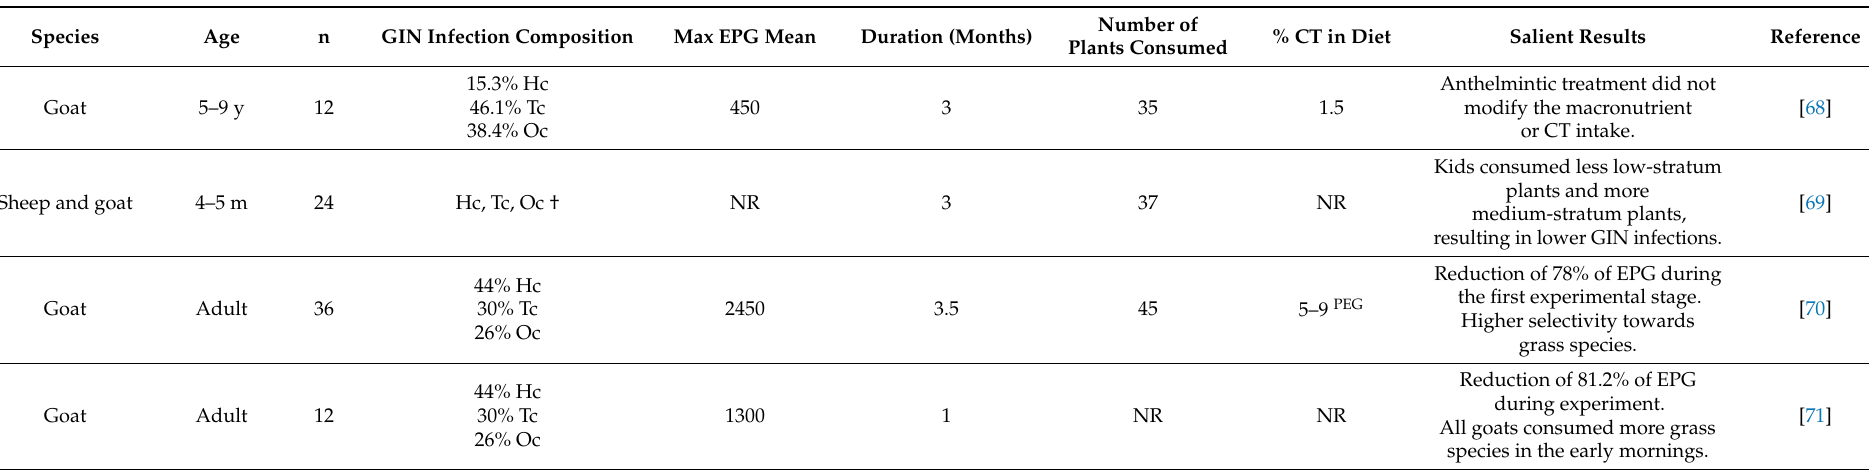
Table 3. Interactions between the natural gastrointestinal nematode infection and the feeding behavior of sheep or goats when browsing the foliage of the plant species present in the low deciduous forest of M é xico. All the studies were performed during the rainy season (between June and October) and employed a continuous bite monitoring methodology for feeding behavior